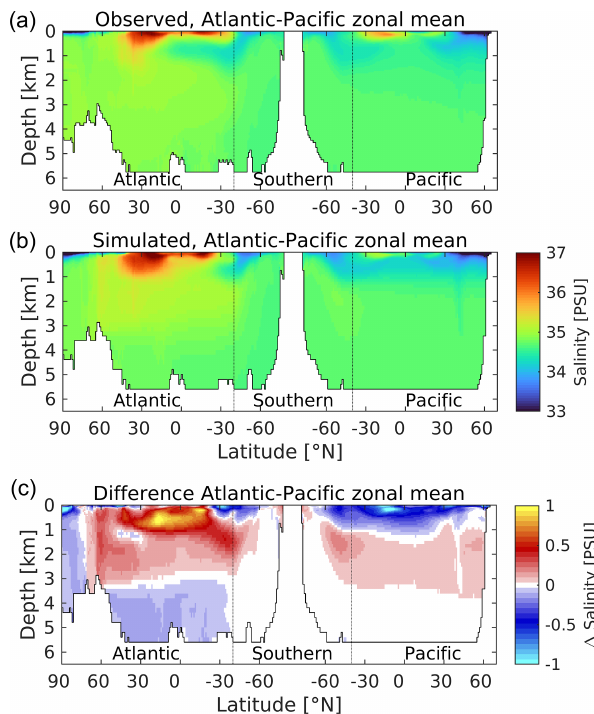
Figure 7. A thermohaline circulation section of observed (a) and modelled (b) zonal average salinity. Difference (simulated– observed) is shown in (c) . Salinity is given in practical salinity units (PSU). Figure 6 explains the format of this